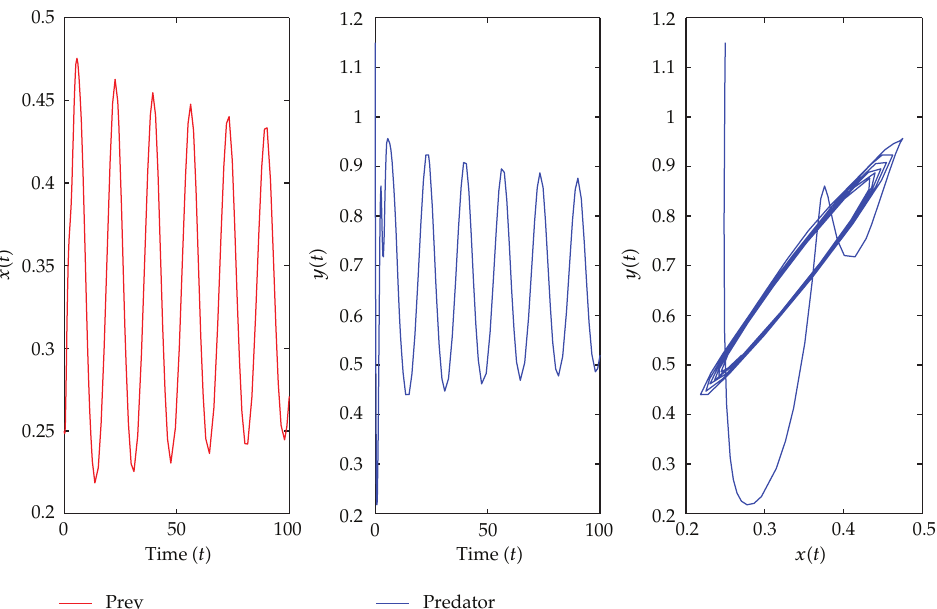
Figure 8: E (cid:7) 0 . 3333 , 0 . 6666 (cid:8) is unstable when τ 1 (cid:6) 4 . 15 > τ 1 ∗ (cid:6) 3 . 7457 with with τ 2 (cid:6) 0 . 5 and initial value 0.25,